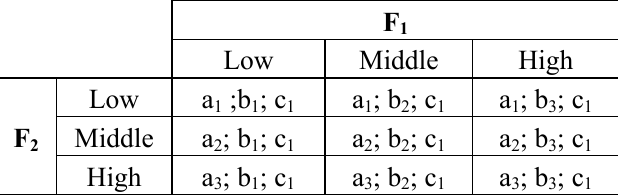
Table 3. Optimized classification among three object